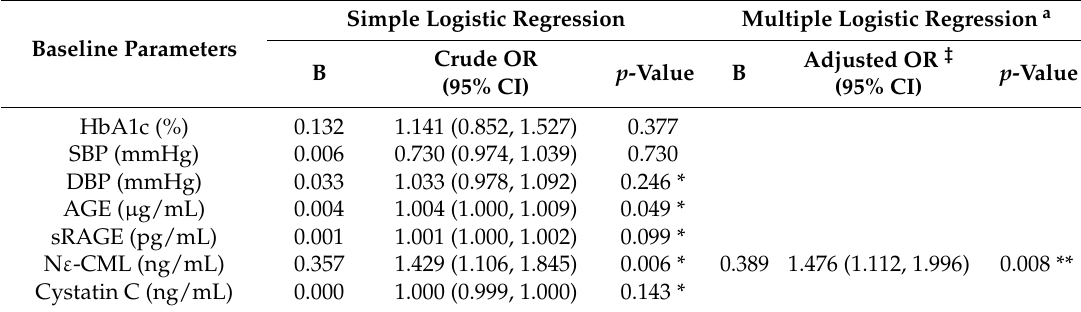
Table 6. Simple and multiple logistic regression.